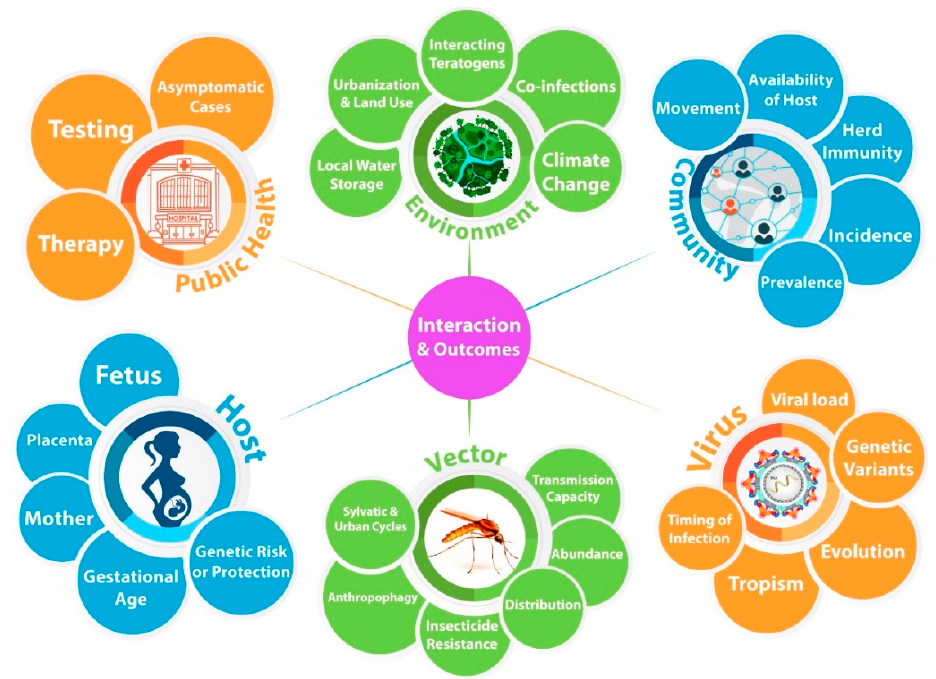
Figure 2. A model to consider possible modifiers of phenotypic variability in neurodevelopmental outcomes toward the long-term goal of prenatal precision therapies. There are likely primary drivers of neurodevelopmental disabilities. Moving clockwise, primary drivers include the environment, community, virus, vector, host, and public health efforts. Each primary driver is composed of highly interdependent factors. Epidemiologic, biomedical, and entomology research suggests the interaction among primary drivers can be additive, synergistic, or antagonistic. In multiple ways, the primary drivers are mutually interdependent in their outcomes. In order to develop personalized therapies to prevent neurodevelopmental disabilities, it is critically important to understand how (and when) these variables increase or decrease the risk of disease and to further delineate how they interact. In this way, personalized treatments or prevention strategies can be considered prenatally for viral infections, and other disorders affecting the developing brain.